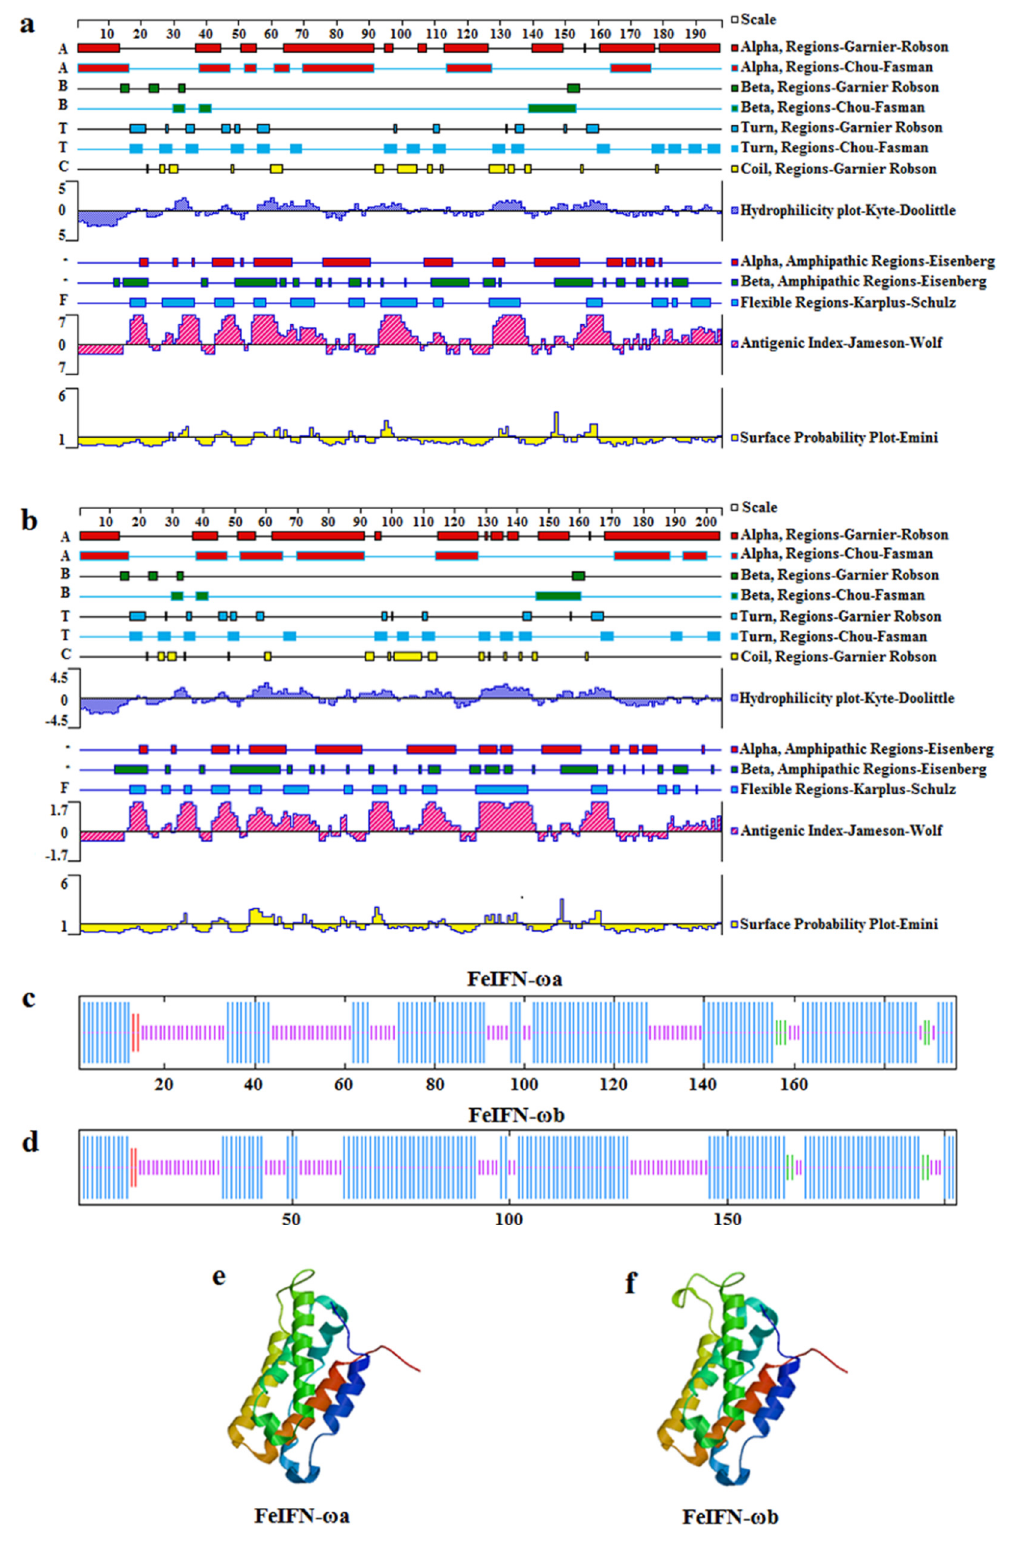
Figure 3. Prediction of antigen epitopes, hydrophobicity, secondary structure, and three-dimensional structure of the newly identified feline IFN- ω proteins. ( a ) The predicted antigen epitopes and hydrophobicity of feIFN- ω a. ( b ) The predicted antigen epitopes and hydrophobicity of feIFN- ω b. ( c ) The predicted secondary structure of feIFN- ω a. ( d ) The predicted secondary structure of feIFN- ω b. ( e ) The predicted three-dimensional structure of feIFN- ω a. ( f ) The predicted three-dimensional structure of feIFN- ω b.